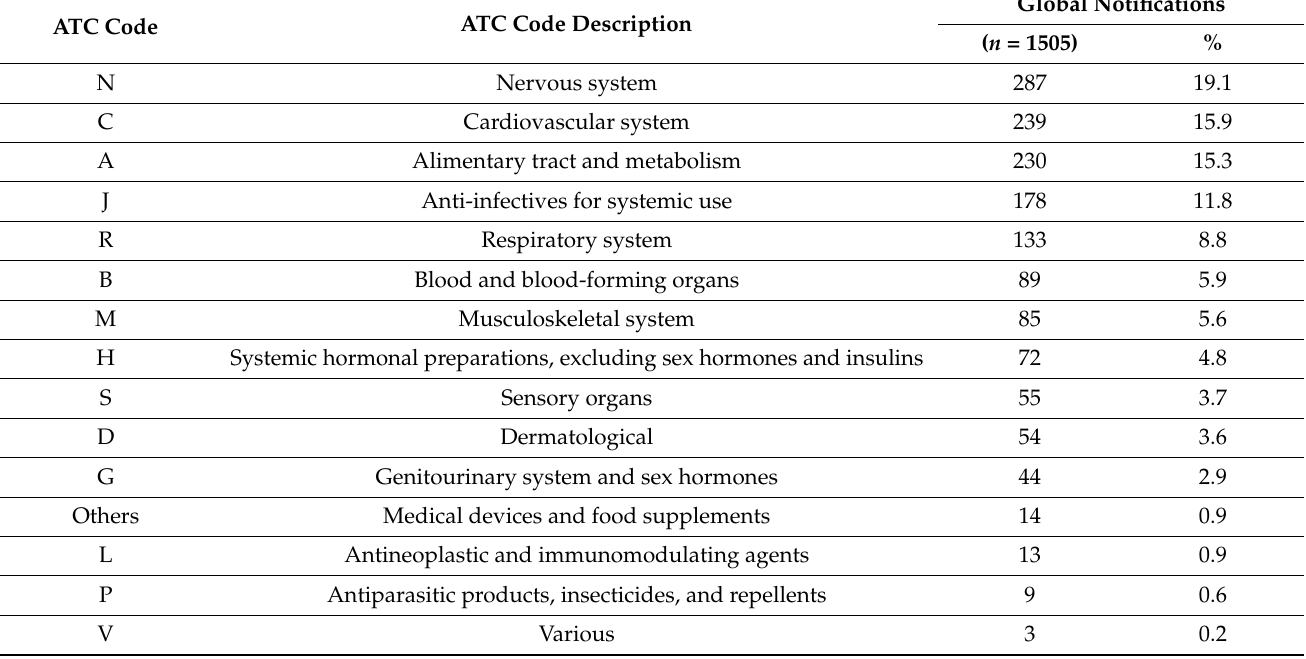
Table 3. Numbers and percentages of drugs involved in the MEs reported according to the organ or system on which the drug acted, based on ATC code descriptions (Catalonia, 2019–2021).